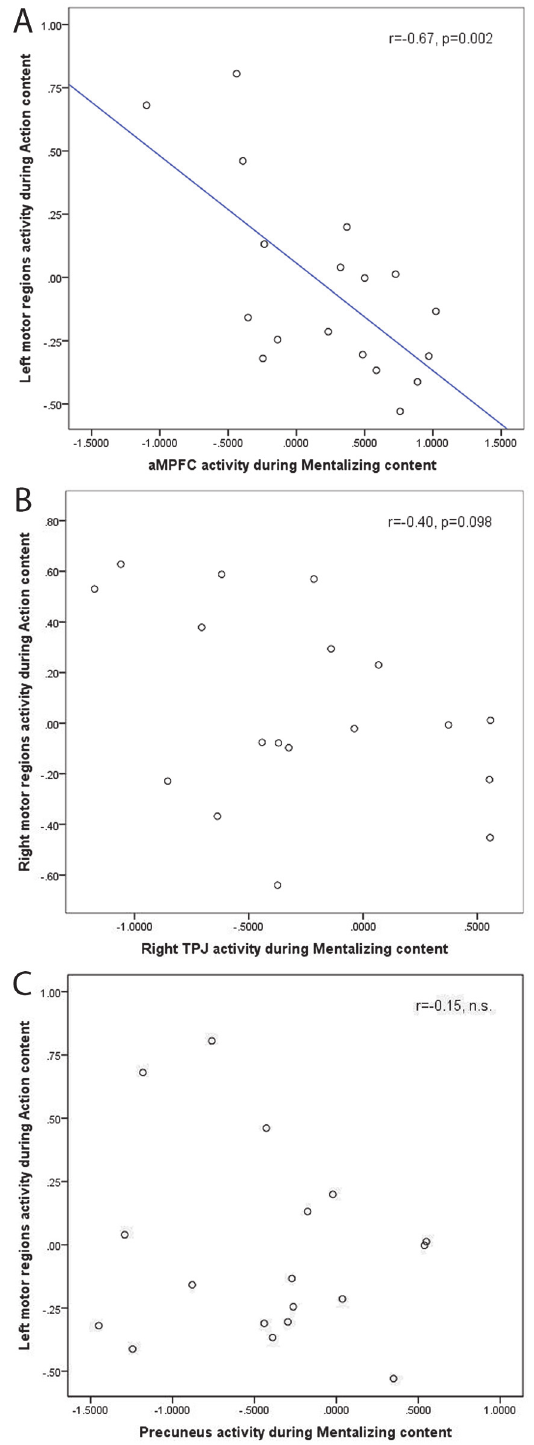
Fig 2. Results of the correlation analysis. Scatter plots of activation levels (beta weights) of Mentalizing regions (x-axes) while participants listened to mentalizing content, and activation in Motor regions while participants listened to Action content (y-axes). A ) There is a negative correlation between Mentalizing regressor activity in the aMPFC mentalizing ROI (x-axis) and Action regressor activity in the left precentral action ROI (y-axis). This illustrates the individual differences in engaging with fiction, with a gradient